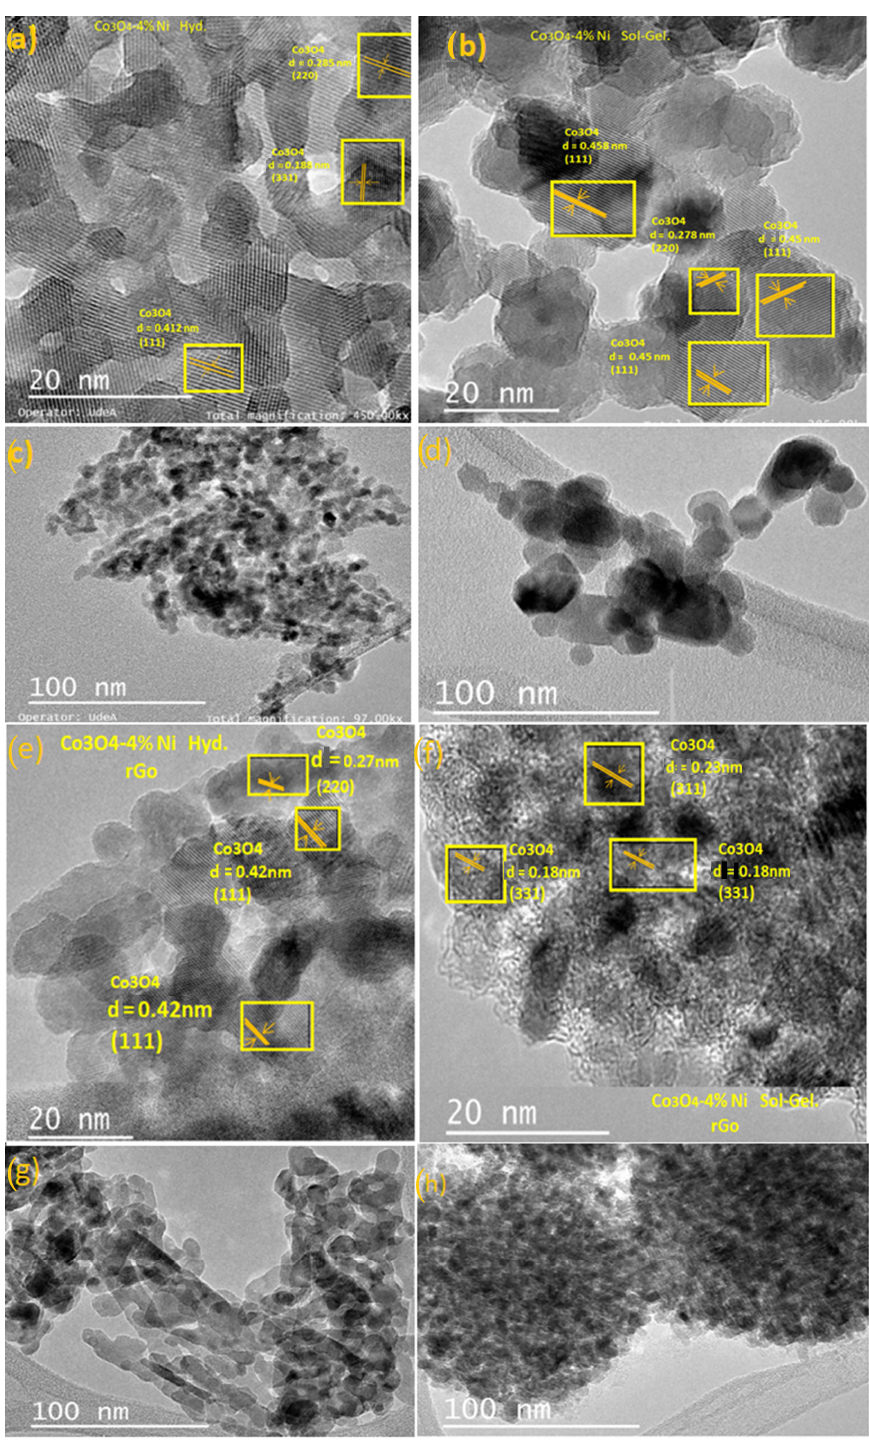
Figure 4. TEM images of Co 3 O 4 samples with 4% Ni at 400 ° C: ( a ) Co 3 O 4 -4%Ni HT , ( b ) Co 3 O 4 -4%Ni SG , ( c ) Co 3 O 4 -4%Ni HT particle size, ( d ) Co 3 O 4 -4%Ni SG particle size, ( e ) Co 3 O 4 -4%Ni+rGO HT , ( f ) Co 3 O 4 -4%Ni+rGO SG , ( g ) Co 3 O 4 -4%Ni+rGO HT particle size, and ( h ) Co 3 O 4 -4%Ni+rGO SG particle size.